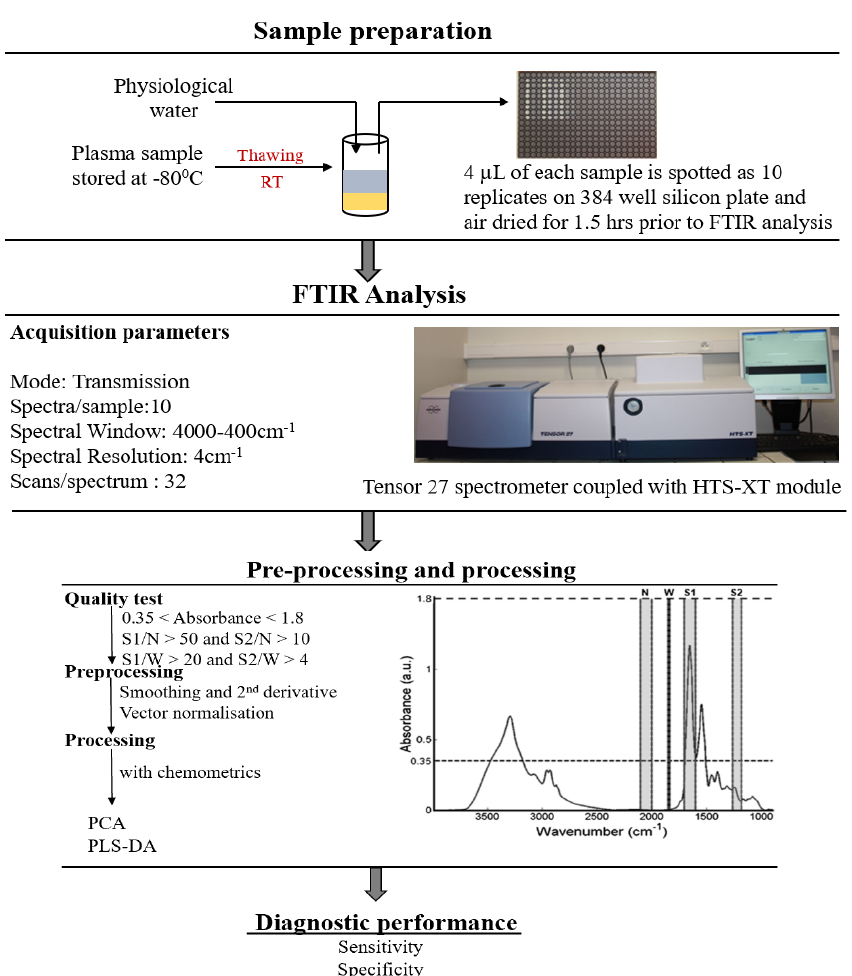
Figure 9. Experimental protocol of high throughput (HT)-FTIR analysis of blood plasma samples from sample preparation to data analysis (reproduced from [23] with permission from The Royal Society of Chemistry). * 3-fold dilution: dilution by volume of one part plasma to two parts physiological water.